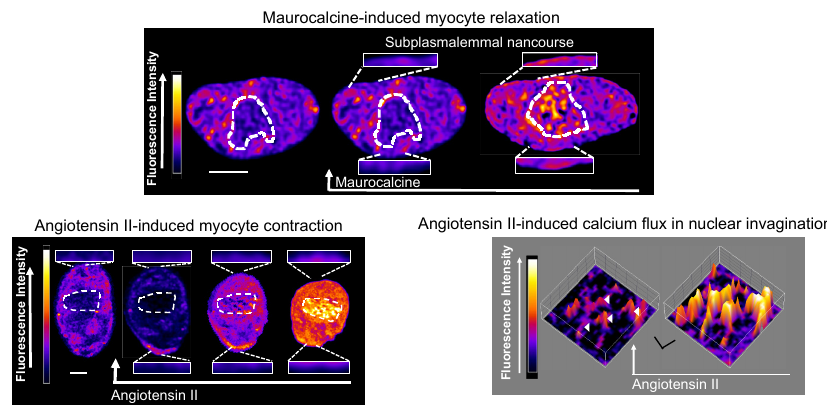
Figure 14. Upper panels, from left to right, show myocyte relaxation in response to RyR1 activation by maurocalcine, with nanocourse-specific changes in calcium flux identified in pseudocolour representations of deconvolved z sections of Fluo-4 fluorescence (scale bar, 2 µ m). Lower left, panels similarly show calcium flux during myocyte contraction induced by angiotensin II (scale bar, 3 µ m). Lower right, panels show angiotensin II-induced increases in calcium flux within nuclear nanocourses of a different cell (scale bar, 1 μ m).